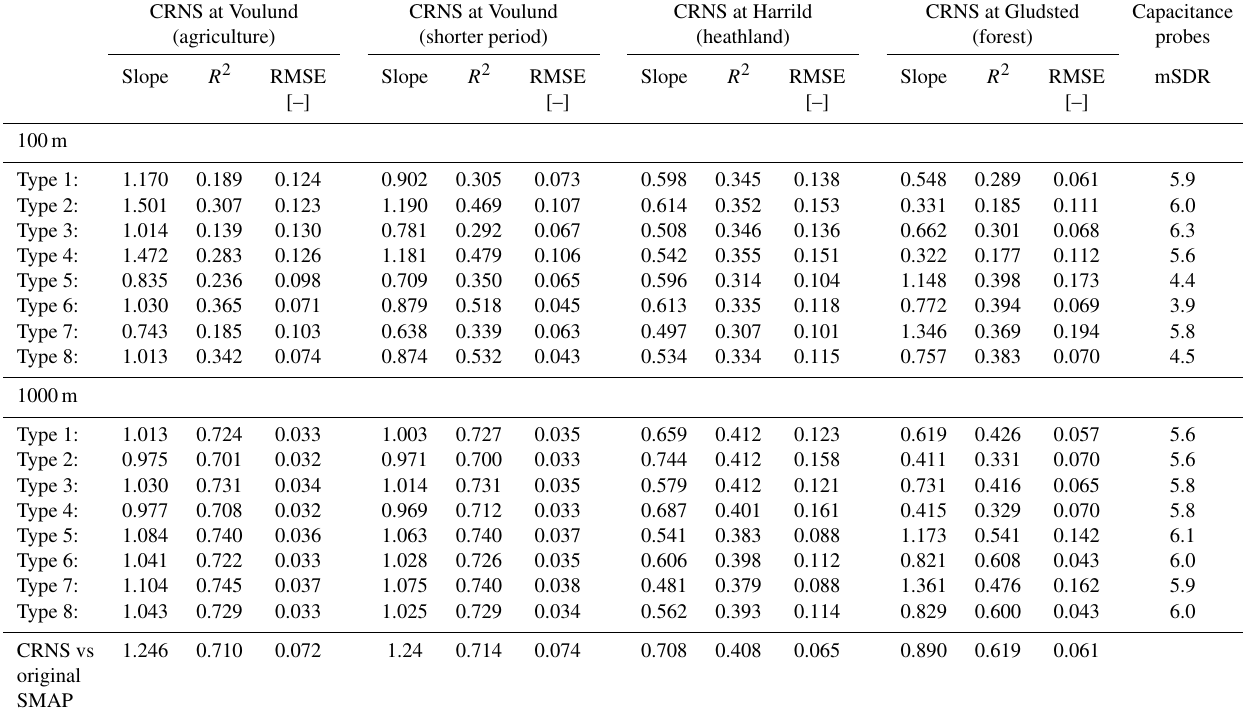
Table 5. Downscaling results: downscaled soil moisture vs CRNS-derived soil moisture at the different field sites; mean difference in rank (mSDR) of downscaled soil moisture compared with capacitance